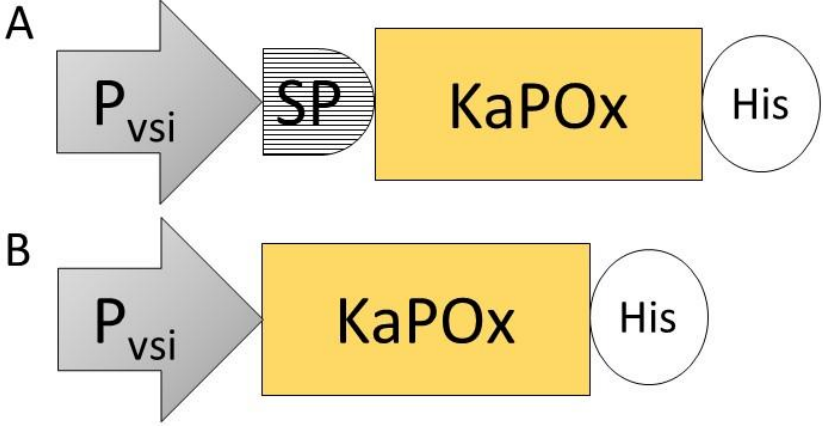
Figure 2. Expression constructs SP Ka POxHis ( A ) and Ka POxHis ( B ), containing the constitutive promoter of the S. venezuelae subtilisin inhibitor gene (P vsi ), the putative signal peptide (SP) identified upstream of the mature domain of pyranose oxidase from K. aureofaciens (KaPOx) and a C-terminal 6× His-tag (His).